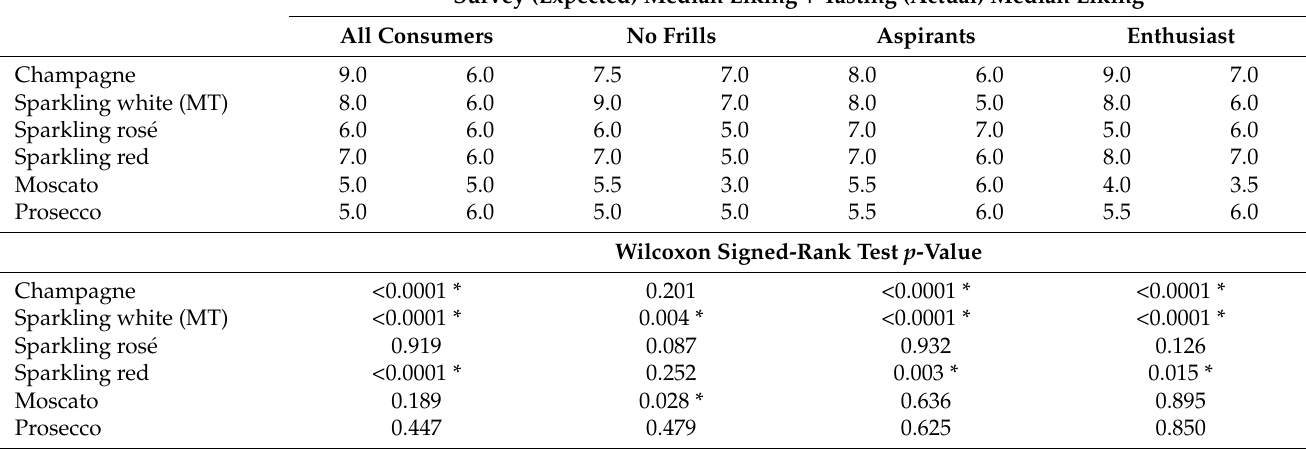
Table 8. Comparison of expected and actual liking scores of consumers and Fine Wine Instrument consumer segments for different sparkling wine